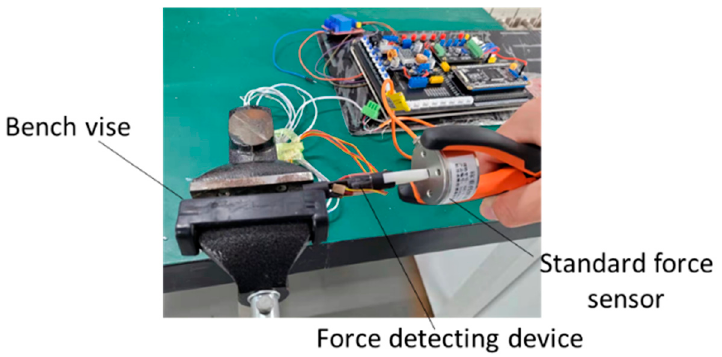
Figure 8. Scene of experimental verification for force detecting performance.